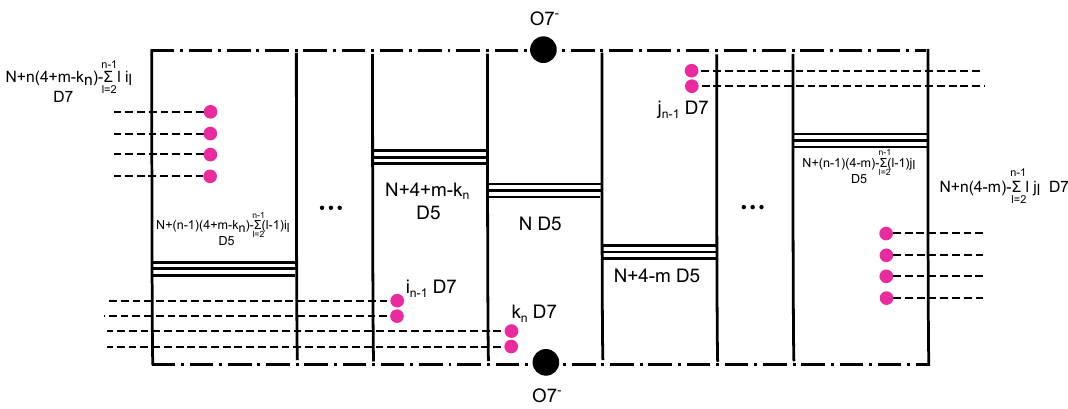
Figure 30 . Type IIB brane con(cid:12)guration after performing a T-duality to (cid:12)gure 22. We de(cid:12)ned non-negative numbers i l ; j l such that they satisfy i l + j l = k l for l = 1 ; 5-branes and two O 7 (cid:0) -planes. The di(cid:11)erence from the cases in section 4.1.2 is that